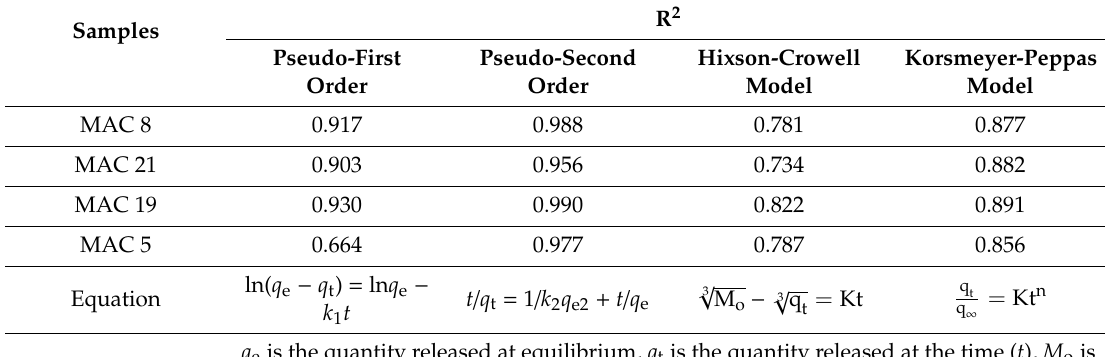
Table 7. The correlation coe ffi cients ( R 2 ) obtained by fitting the MET release data from MET-CS-AlgNPs